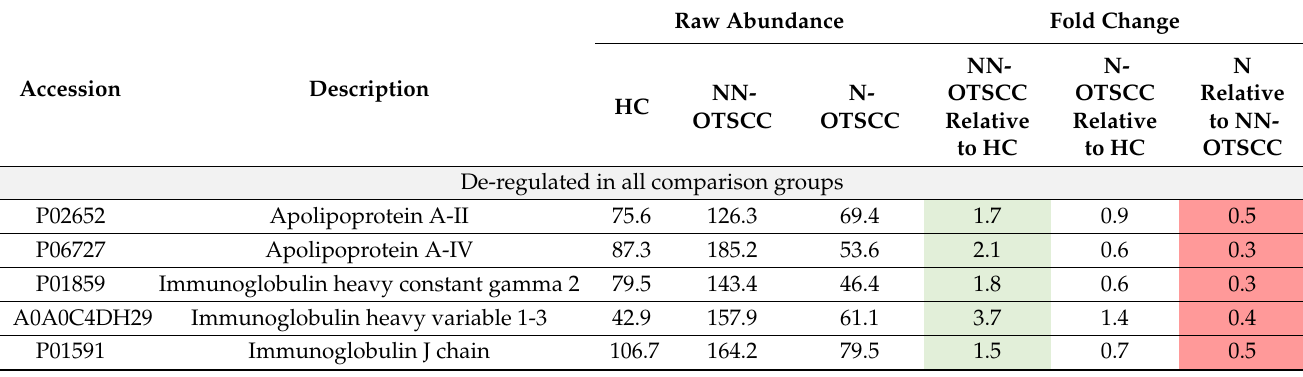
Figure 3. Kaplan-Meier analyses showing the relationship between survival and head and neck tumoral expression of candidate EV associated proteins (actin, serum paraoxonase/arylesterase 1, integrin alpha-3, myosin-9, and agrin). Survival curves of individual proteins were generated using UALCAN and the effect of combined expression of all 5 proteins was generated using Kaplan-Meier plotter [18]. Similar to many other proteomic studies, we identified a number of classical, high abundant, plasma proteins [13,19,29]. Quantitative analyses of this sub-group of EV associated proteins revealed that a lower percentage (37%, 22 out of 59) changed in abundance between groups when compared with candidate EV proteins (Table 3). Intriguingly, apolipoproteins were increased in non-nodal OTSCC relative to non-cancer controls but decreased in nodal OTSCC relative non-nodal disease. Similar trends were observed for some immunoglobulins, keratin and serrotransferrin. Table 3. Top most deregulated classical, high abundant, plasma EV-associated proteins between healthy controls and oral tongue cancer. Proteins that increase or decrease in expression by 1.5 fold or greater are shaded in green or red respectively. Healthy controls (HC), non-nodal oral tongue squamous cell carcinoma (NN-OTSCC), nodal oral tongue squamous cell carcinoma